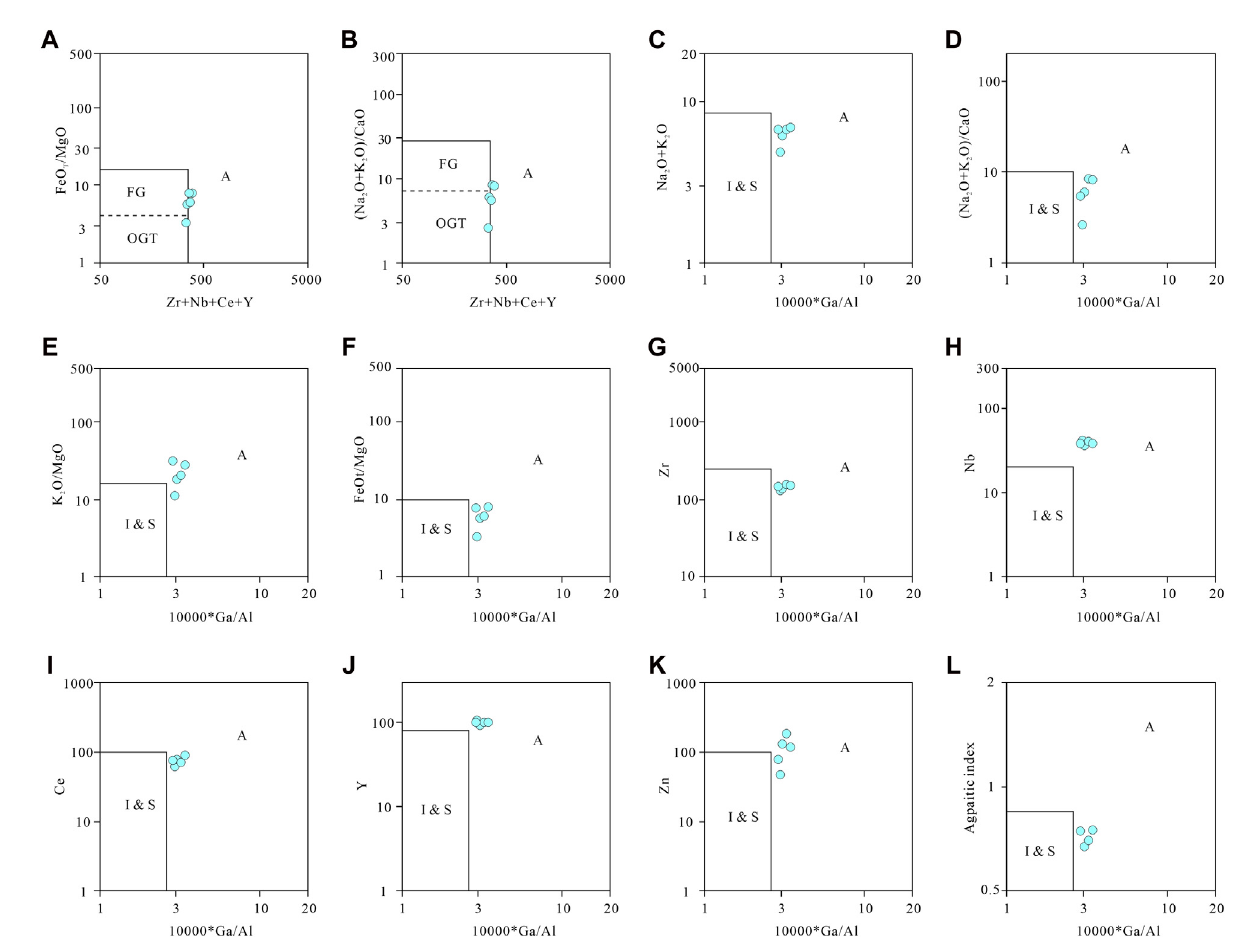
FIGURE 11 Plots to distinguish A-type granites (Whalen et al., 1987). Abbreviations: FG, fractionated felsic granites; OGT, unfractionated M-, I-, and S-type granites. A, A-type granite; I & S, I- and S-type granite.